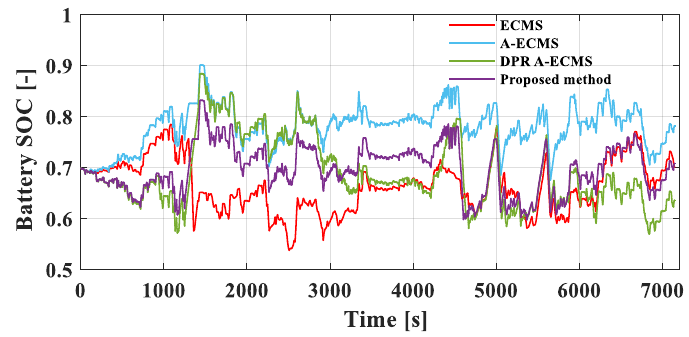
Figure 13. Comparison of the SOC states.